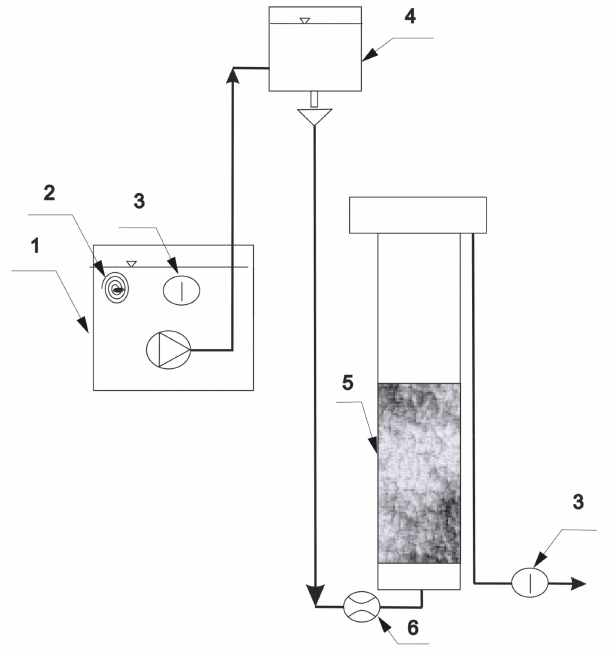
Figure 1. Scheme of laboratory set-up (1—tank with raw water and pump, 2—heater, 3—thermometer, 4—overflow tank, 5—column filled with filter media, 6—flowmeter).